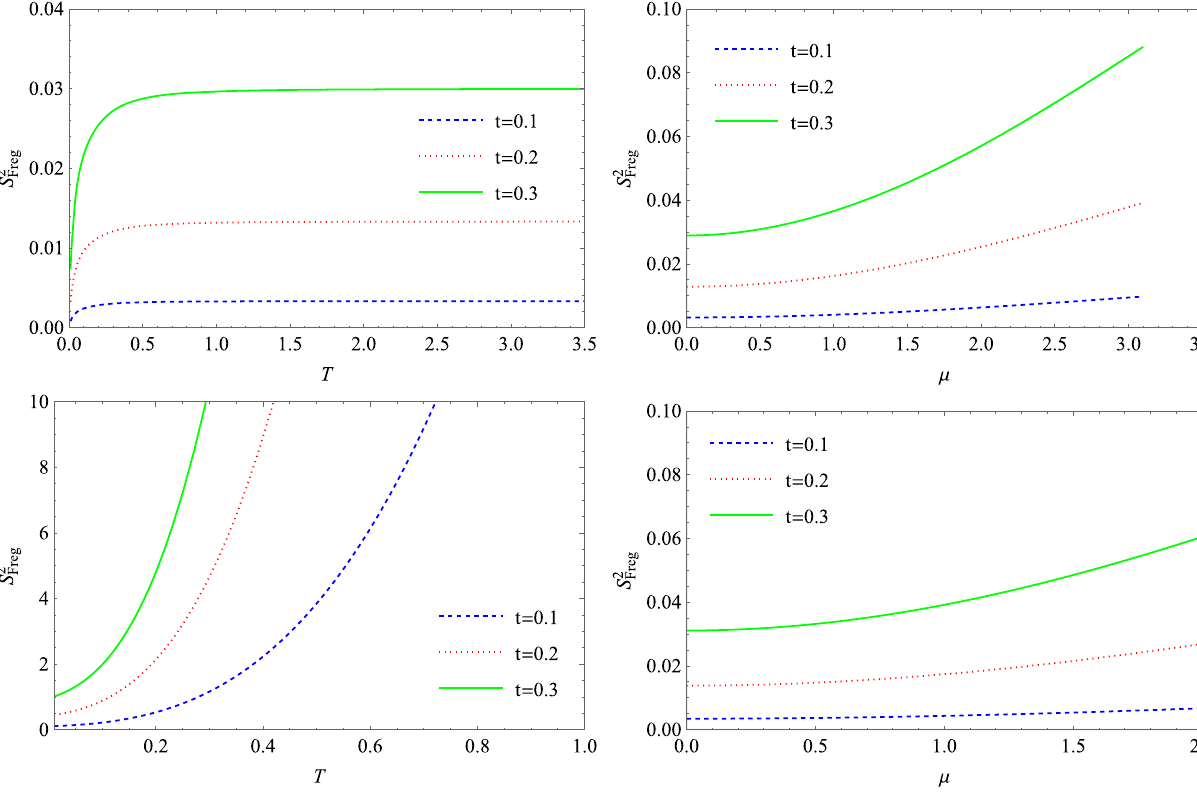
distribution and reproduction in any medium or format, as long as you give appropriate credit to the original author(s) and the source, pro- vide a link to the Creative Commons licence, and indicate if changes were made. The images or other third party material in this article are included in the article’s Creative Commons licence, unless indi- cated otherwise in a credit line to the material. If material is not included in the article’s Creative Commons licence and your intended use is not permitted by statutory regulation or exceeds the